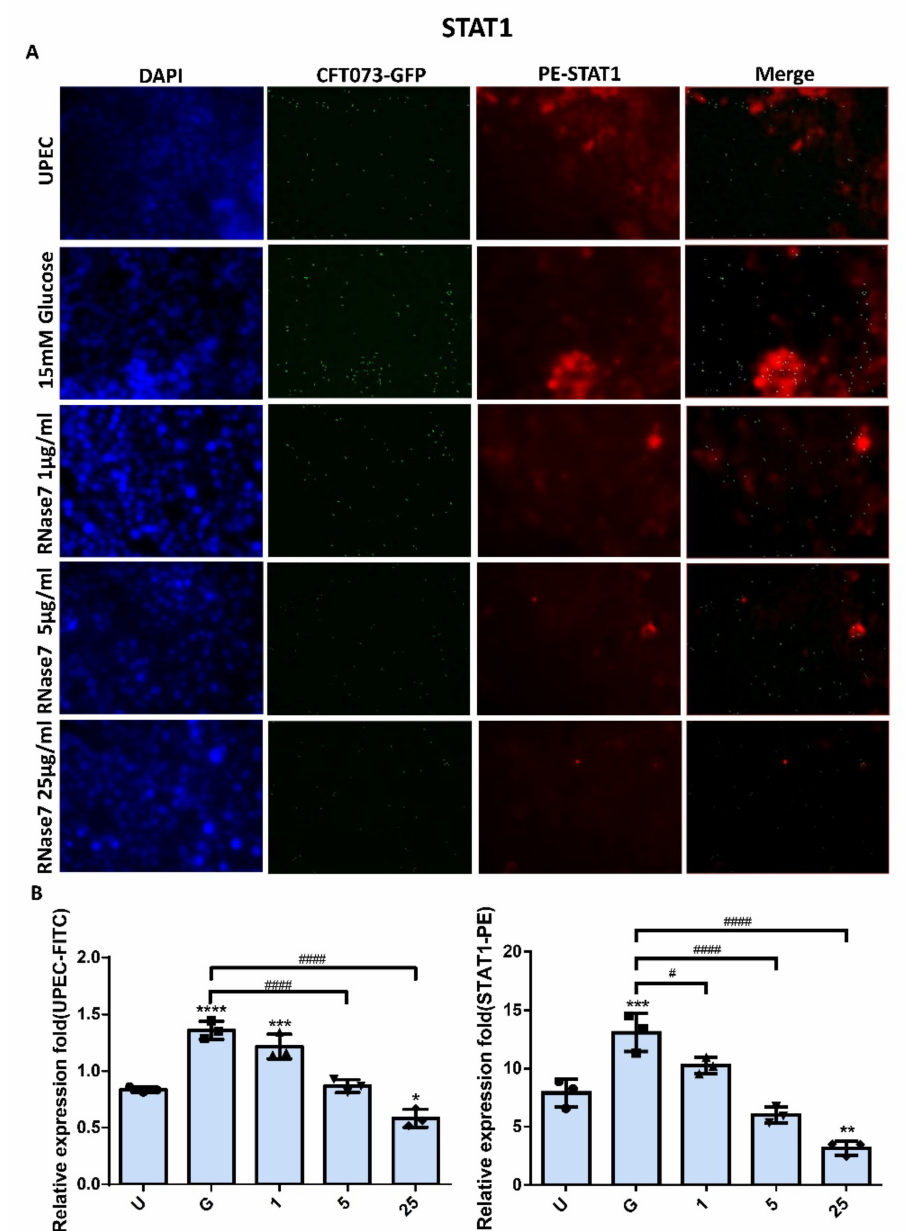
Figure 2. RNase 7 affected UPEC infection and STAT1 expression in bladder cells. After 24 h of pretreatment with different concentrations of RNase 7 (1, 5, and 25 µ g/mL) and 15 mM glucose, GFP- UPEC and PE-STAT1 expression in SV-HUC-1 cells post-infection were ( A ) observed by fluorescence microscopy and ( B ) measured using ImageJ software. Cells infected with UPEC alone were used as the positive controls. The data shown are representative of a typical result. DAPI was used to count the number of cells and as a standard for calculating the fluorescence expression ratio of cells. Cell images were captured using a microscope (Leica) at 100 × magnification. The definitions of each letter/number represented by the X axis are: U: UPEC infection alone; G: with 15 mM glucose pretreatment alone; 1, 5, and 25: pretreated with 1, 5, and 25 µ g/mL RNase 7, respectively, + 15 mM glucose. Data are expressed as the mean ± SD of three independent experiments. * p < 0.05, ** p < 0.01, *** p < 0.001, **** p < 0.0001, compared to UPEC infection control groups. # p < 0.05, #### p < 0.0001, compared between the two